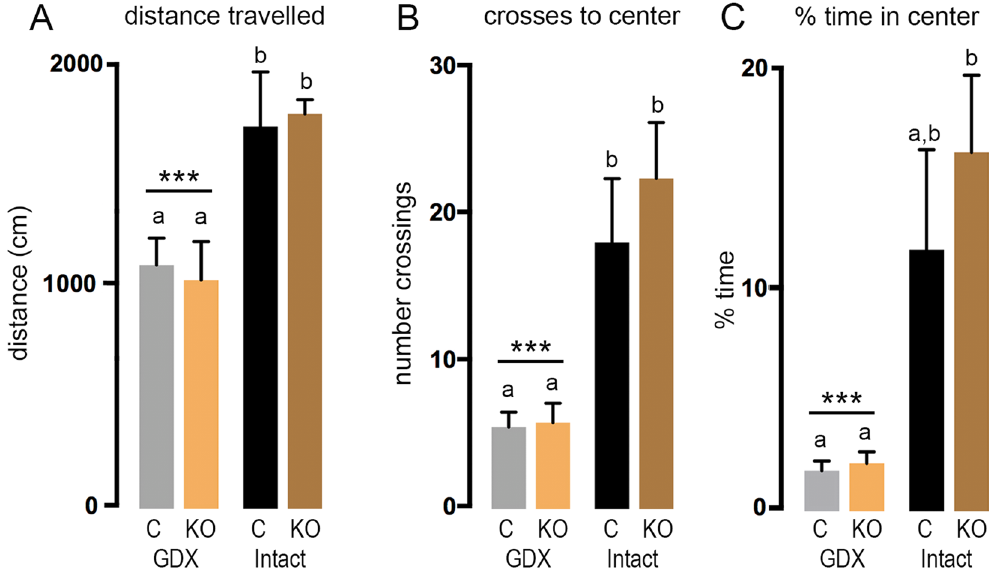
Figure 2. Open field trial performance of gonadectomized (GDX) and intact KISS1R-KO mice. Different letters above histograms indicate statistically significant differences between GDX control (GDX C; N = 9), GDX KISS1R-KO (GDX KO; N = 7), intact control (Intact C, N = 8) and intact KISS1R-KO rescue (Intact KO, N = 9) mice. Bars with *** above GDX group indicate significant difference between all GDX and all intact mice for each parameter ( P < 0.001, 2-way ANOVA). ( A ) Histograms showing average total distance travelled over the 3 trials. b vs. a = P < 0.05, Tukey’s post-hoc multiple comparisons. ( B ) Histograms showing the average number of crossings into the inner quadrant (center) over the 3 trials. b vs. a = P < 0.001, Tukey’s post-hoc